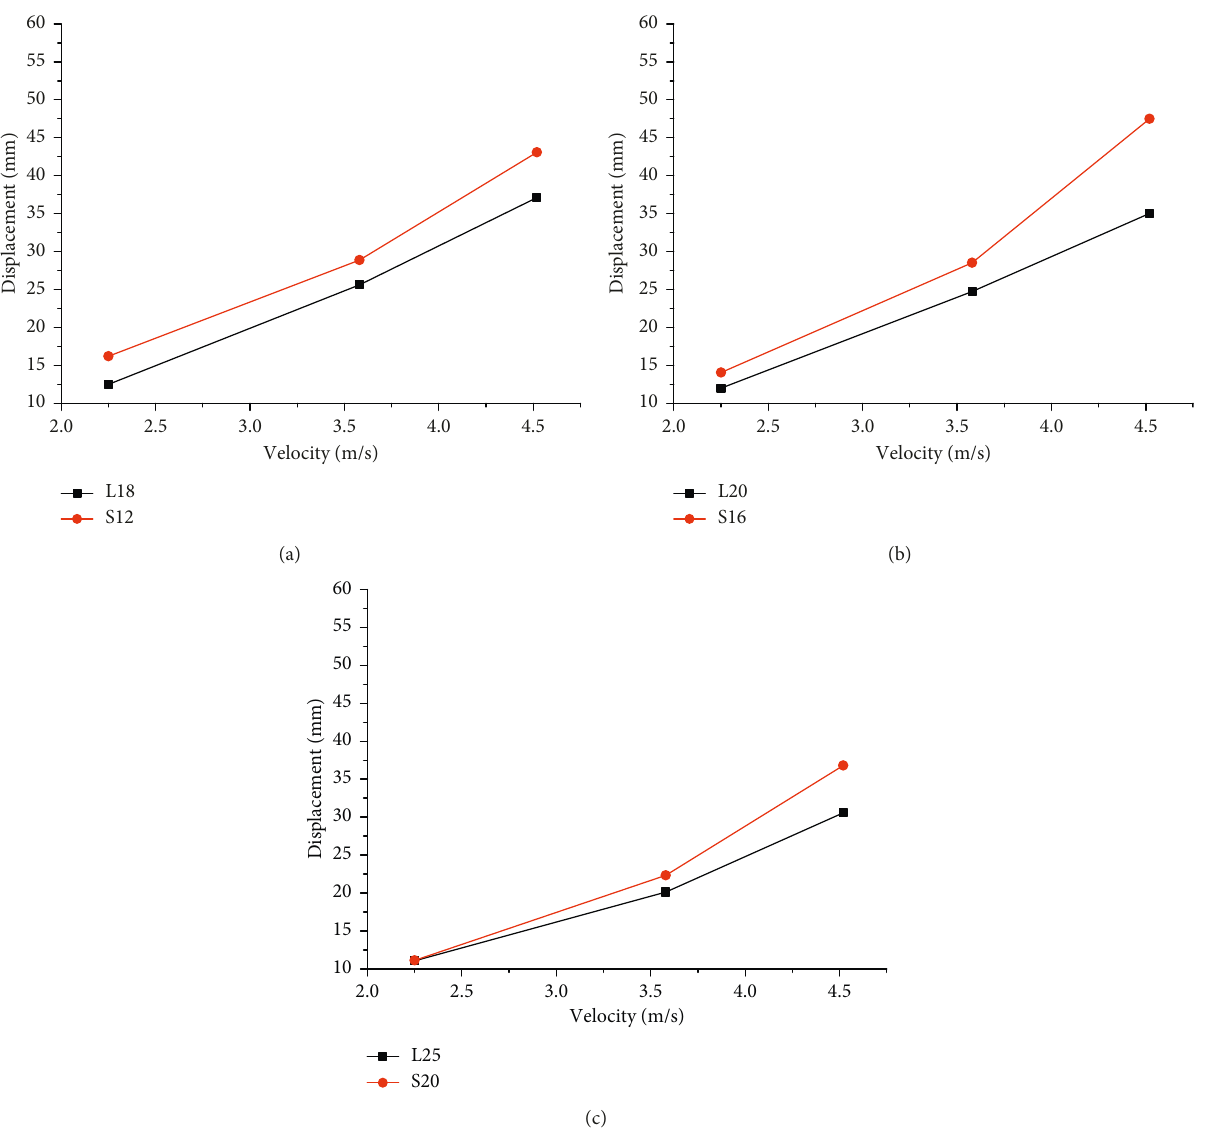
Figure 12: Peak displacements and velocity curves. (a) Group A. (b) Group B. (c) Group